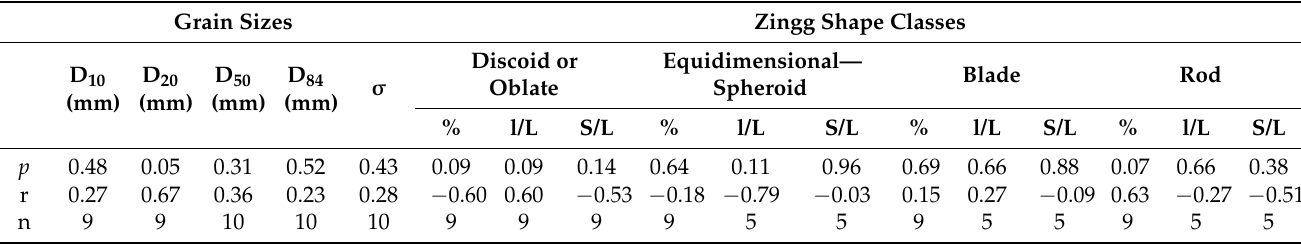
Table 4. Pearson’s correlation